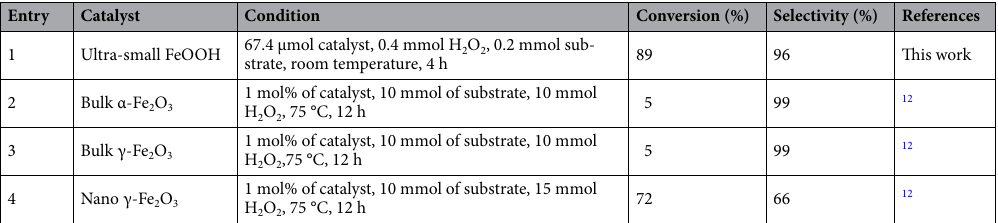
Table 3. Oxidation of organic substrates with different nano-iron oxide catalysts.